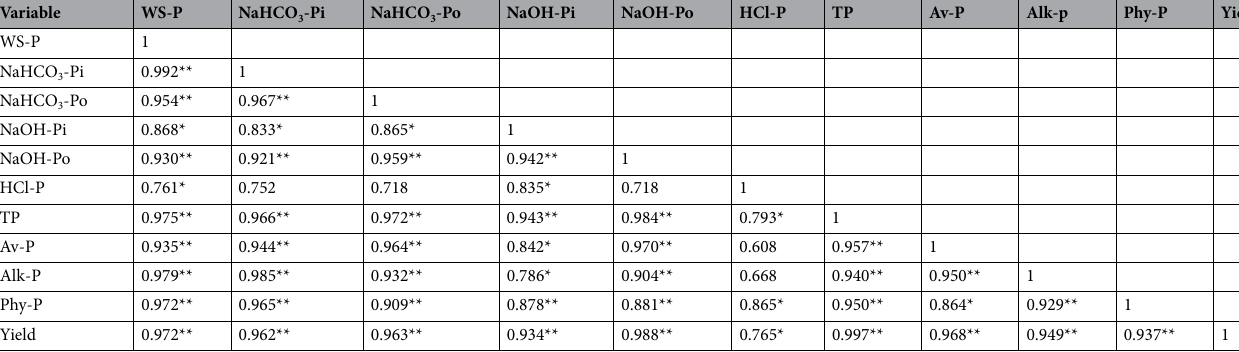
PC1 PC2 Soil variables Loading value Contribution of variables (%) Loading value Contribution of variables